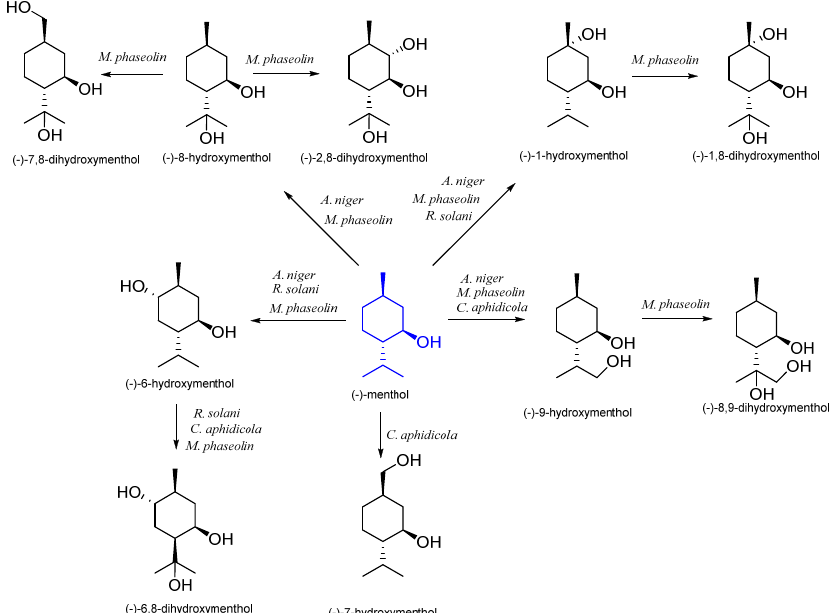
Scheme 10. Microbial biotransformations of ( − )-menthol.